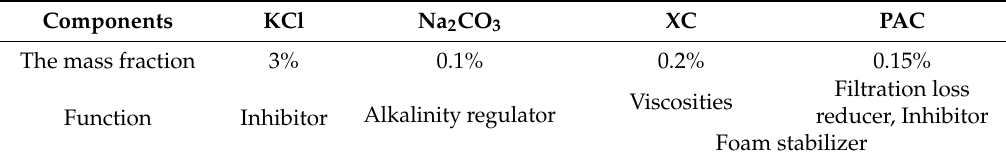
Table 1. The basic fluid